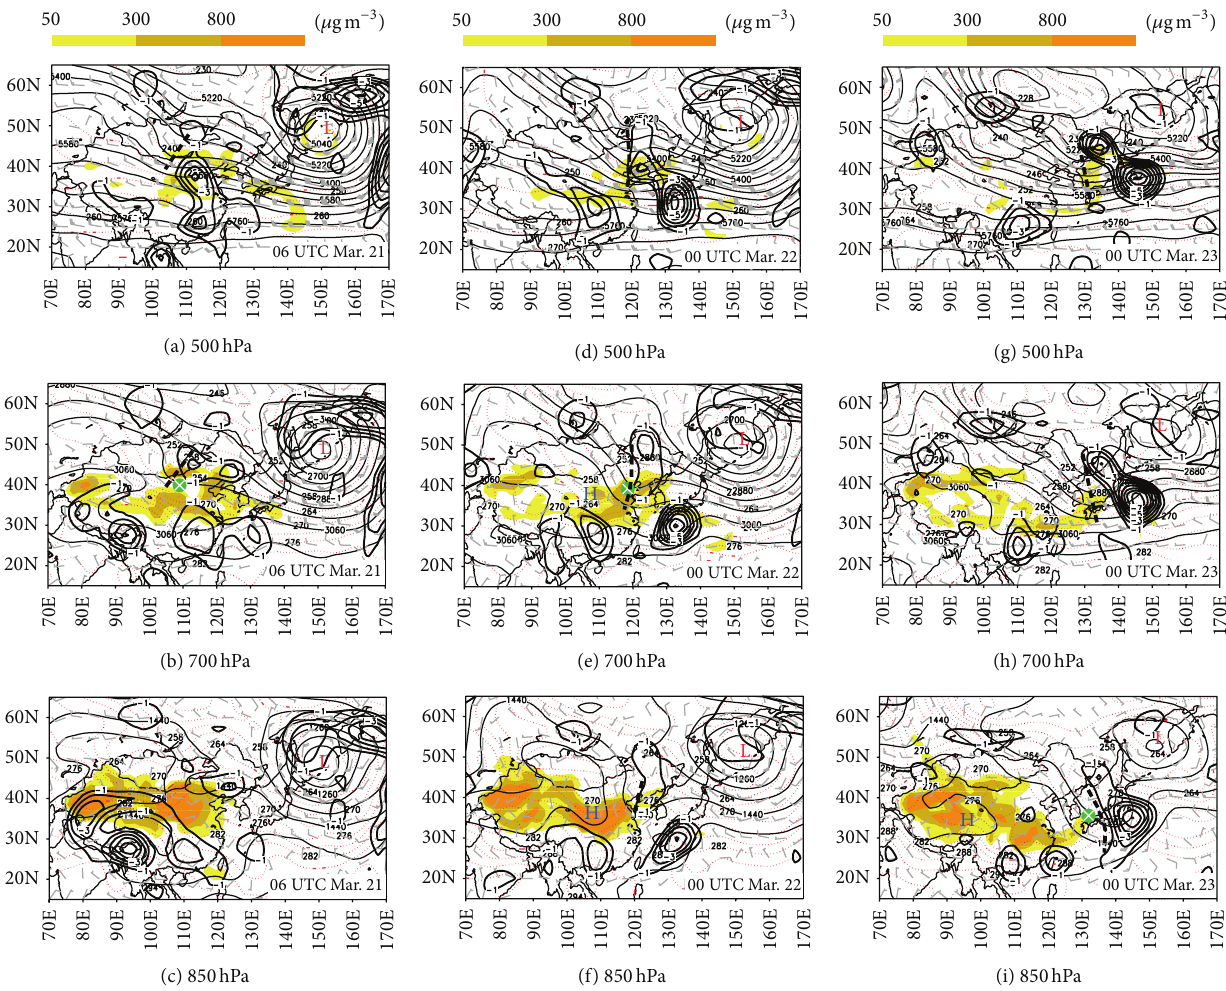
Figure 7: As in Figure 6, but for eastward dust event at 500, 700, and 850 hPa of (a)–(c) 0600 UTC on 21 March, (d)–(f) 0000 UTC on 22 March, and (g)–(i) of 0000 UTC on 23 March, respectively.